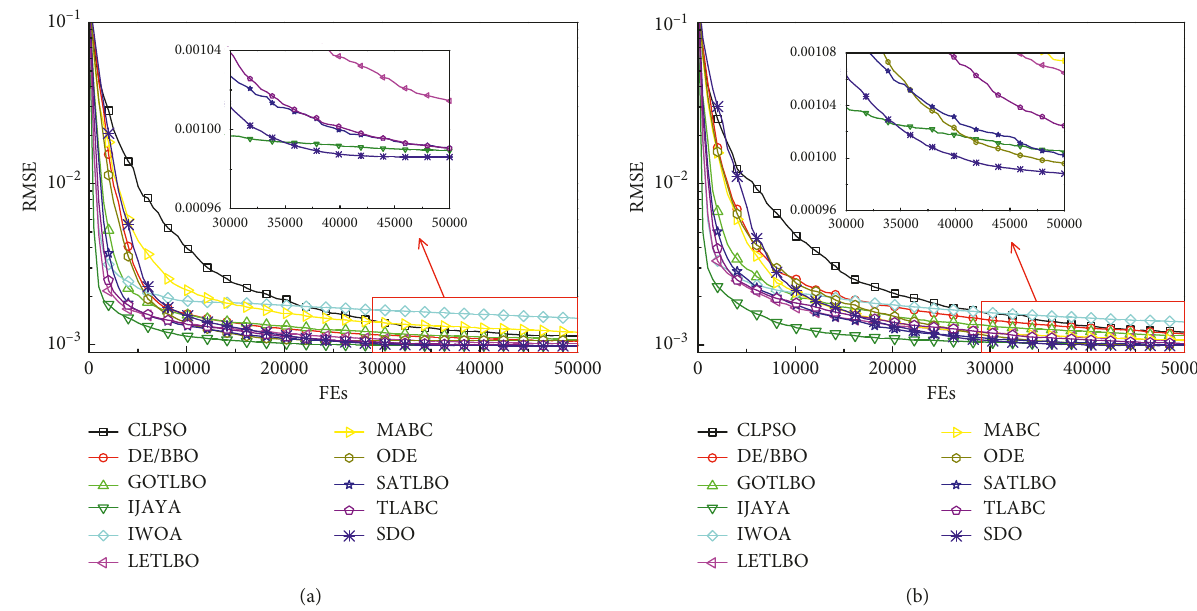
Figure 5: Convergence curves for the RTC France silicon solar cell. (a) SDM; (b)